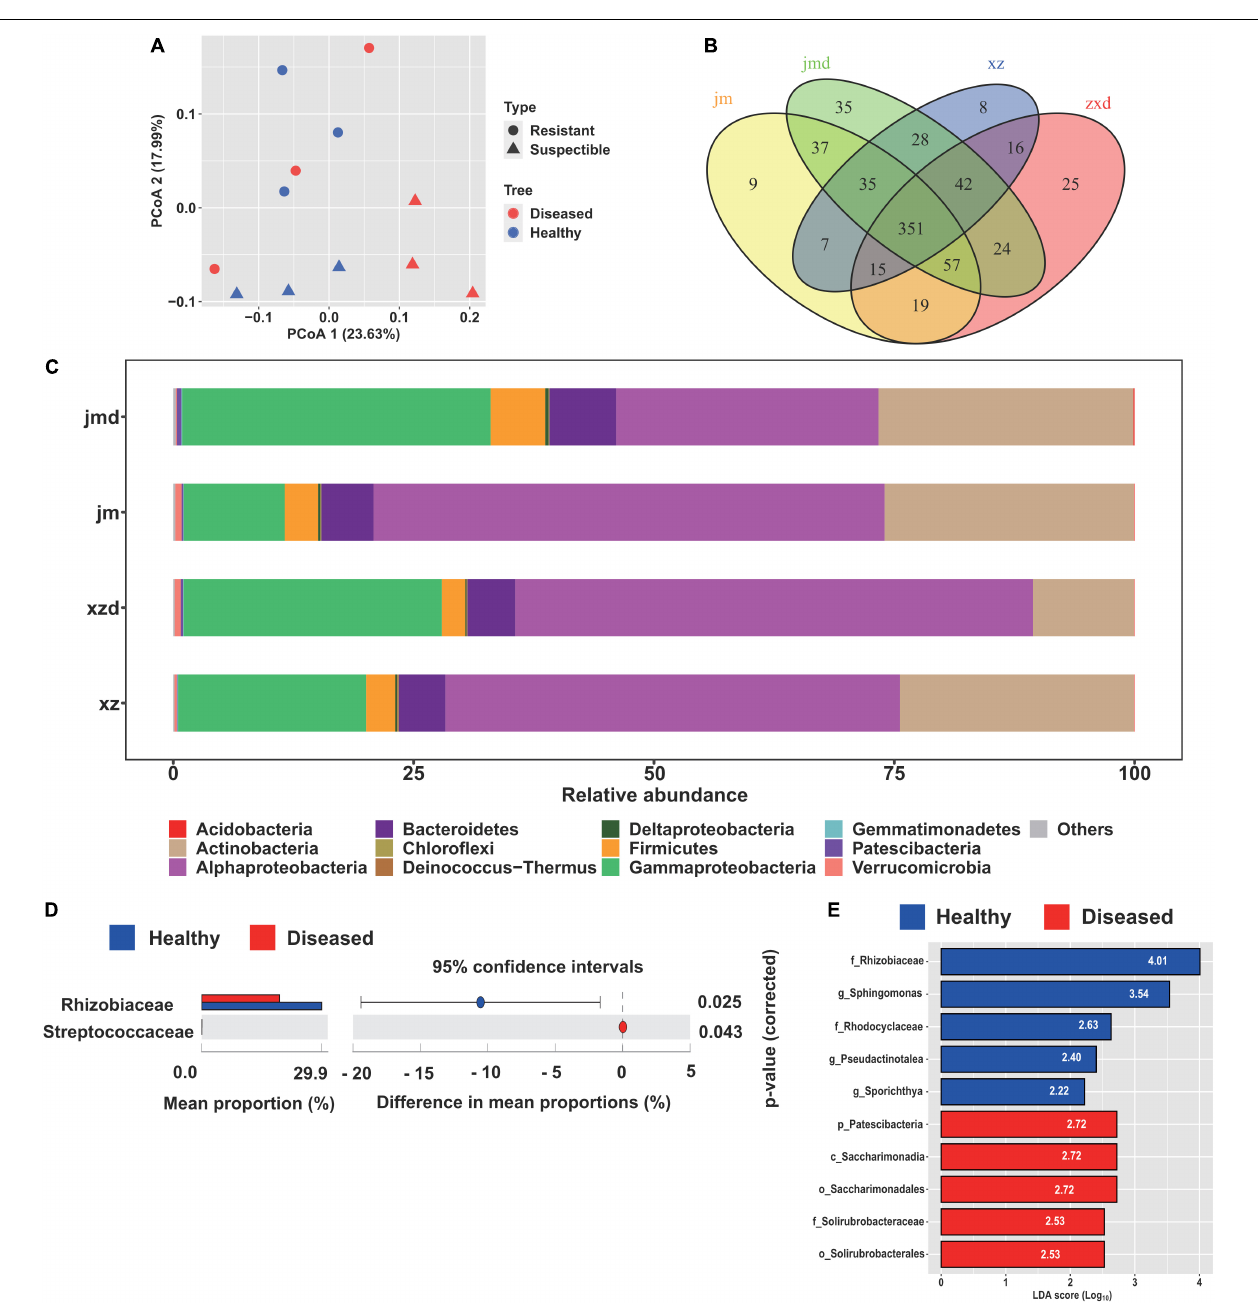
FIGURE 3 | Comparative analysis of the endophytic bacterial community under different healthy conditions. (A) Unconstrained principal coordinate analysis (PCoA) of beta-diversity using Bray-Curtis distances of the bacterial community in healthy and diseased samples. (B) Venn diagrams showing the shared and specific bacterial OTUs among the healthy and diseased samples of different cultivars. (C) Relative abundance of the abundant bacterial taxa in healthy and diseased cotton plants. (D) Differential abundance analysis of bacterial OTUs in healthy and diseased samples, and Welch’s test was performed to calculate the significance of differences at the family level. (E) The biomarker taxa of bacterial communities among healthy and diseased cotton plants. Only the top five most specific biomarker taxonomies are displayed.